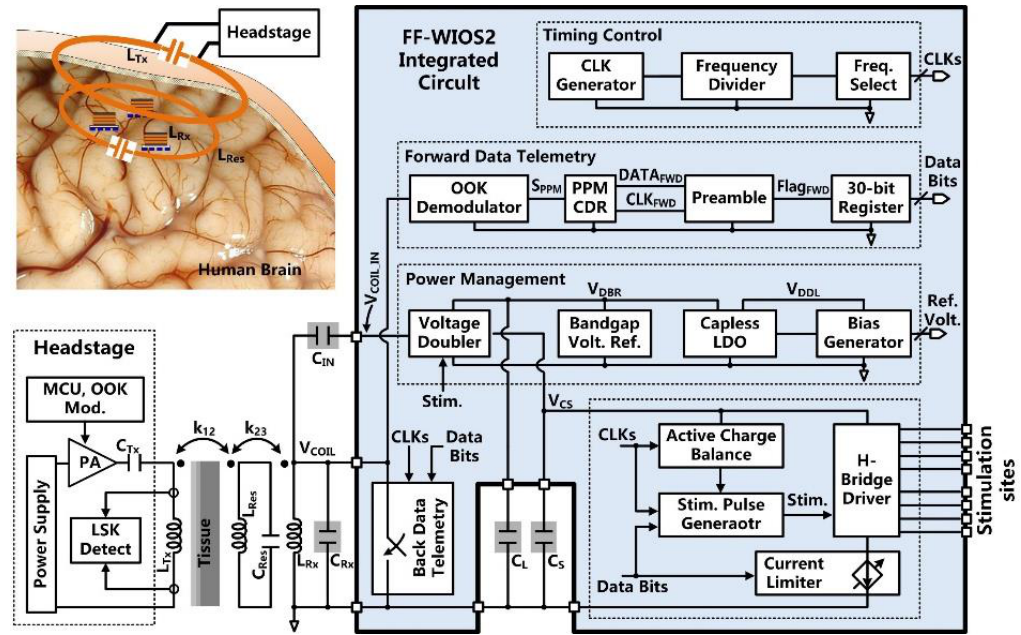
Figure 2. Block diagram of the FF-WIOS2 system-on-chip (SoC) architecture.